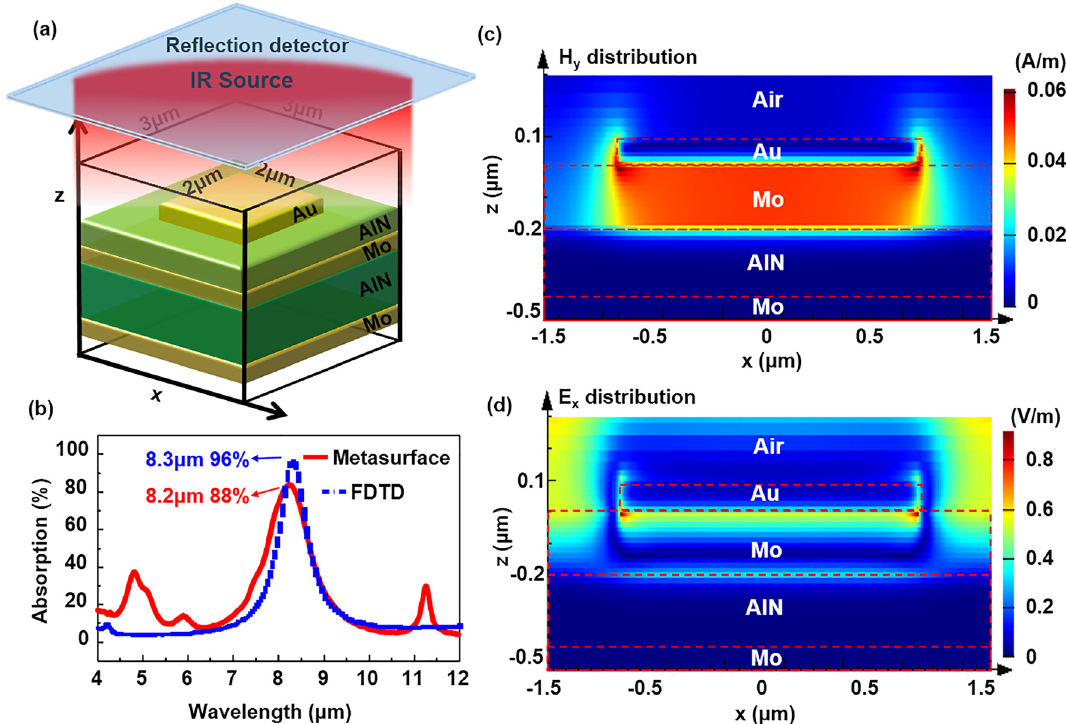
Figure3: (a)Schematicoftheperiodicunitcelloftheperfectmetamaterialabsorber.(b)Simulated(bluedashedline)andmeasured(redsolid line) infrared (IR) absorption spectra of the perfect metamaterial absorber. (c) Magnetic field ( H y component) distribution at a wavelength of 8.3 μ m. (d) Electric fi eld ( E x component)